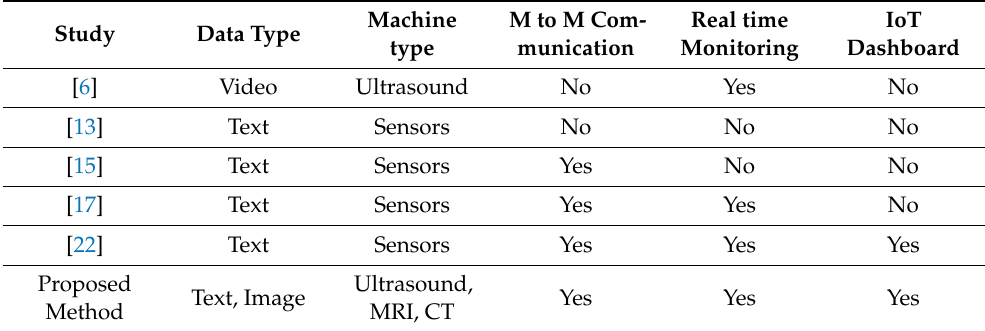
Table 6. Comparison with existing